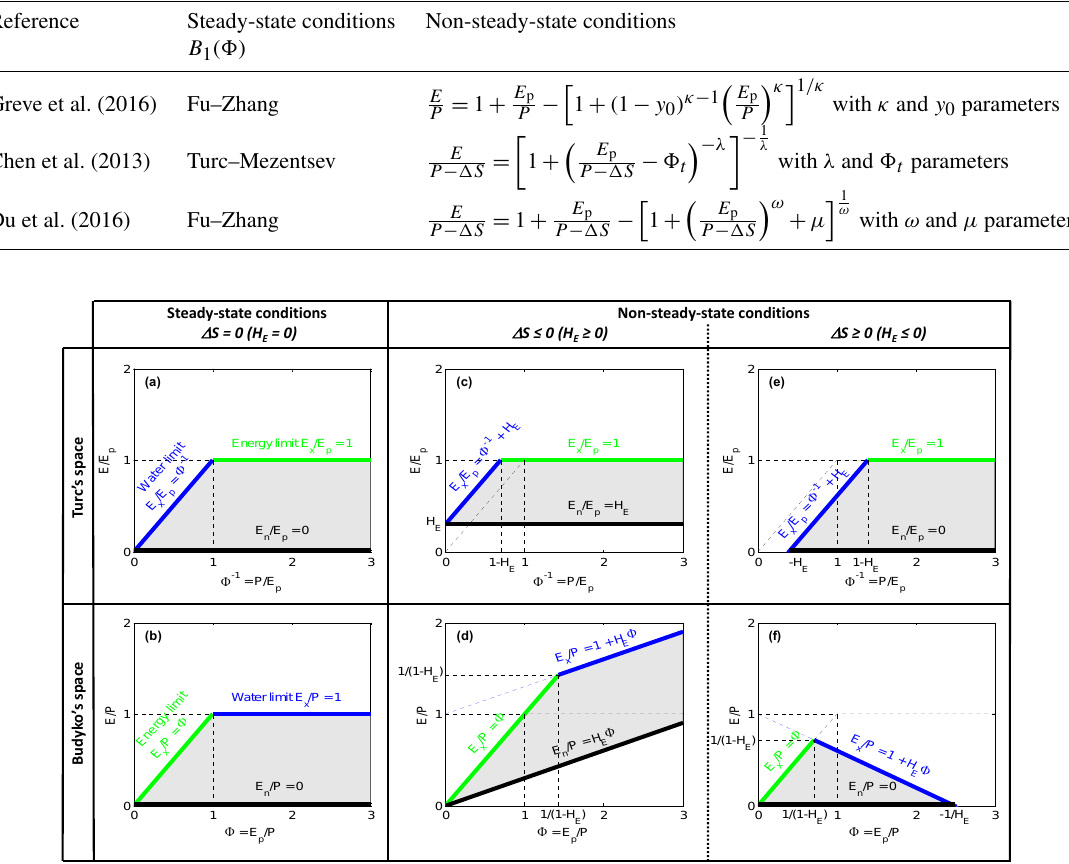
Figure 2. Upper and lower limits of the feasible domain (in grey) of evaporation in the Turc space ( P /E p , E /E p ) and in the Budyko space ( E p /P , E /P ) (water limit in blue, energy limit in green and lower limit in black) when using the non-dimensional parameter H E : ( a and b ) for steady-state conditions; ( c , d , e and f ) for non-steady-state conditions with a storage term (cid:49)S ( c and d for (cid:49)S ≤ 0; and (e) and (f) for (cid:49)S ≥